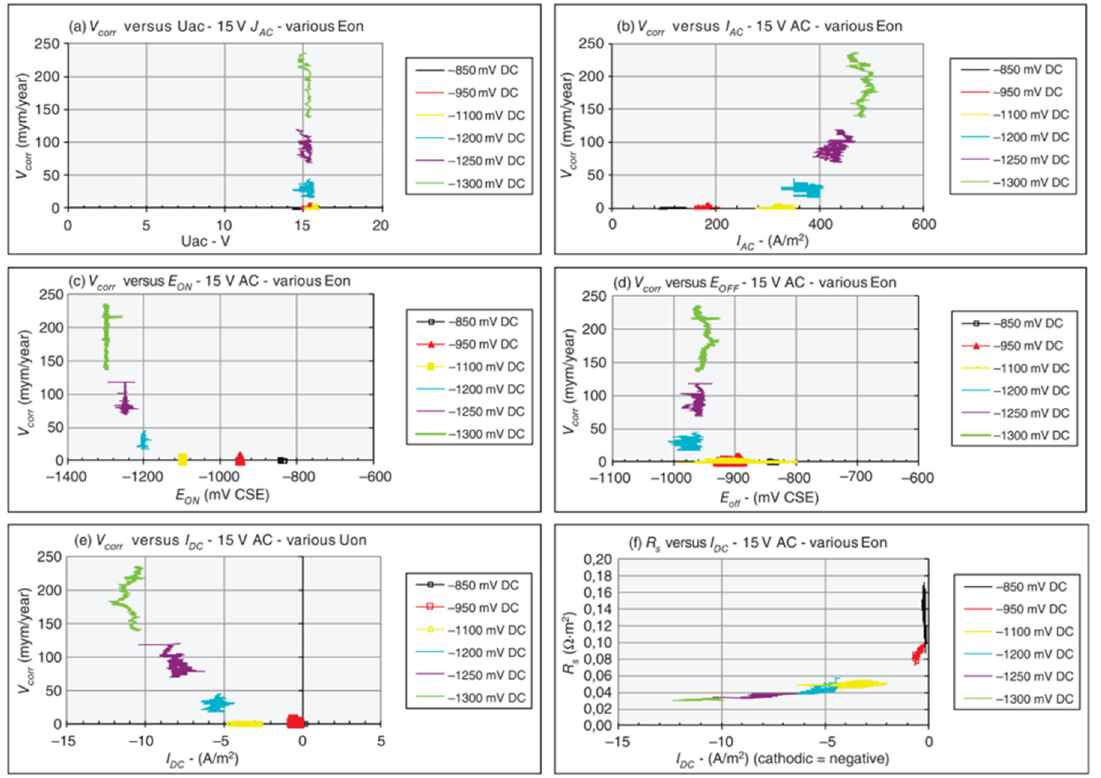
Figure 13. Example of corrosion rate vs. various electrical parameters, as reported by Nielsen [63].